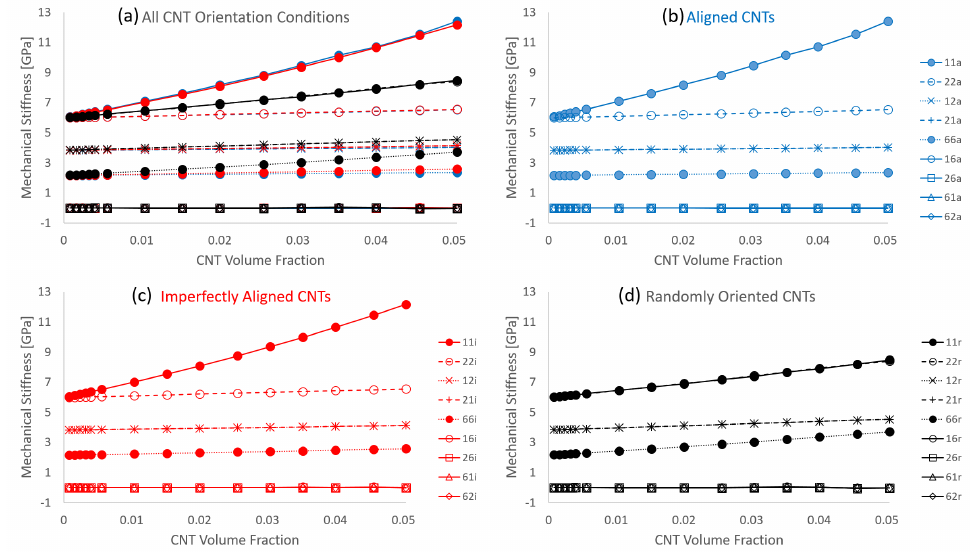
Figure 10. Mean of every stiffness tensor component C ij for ( a ) all 3 different orientation cases with straight CNTs, ( b ) straight ˜ x 1 aligned CNTs, ( c ) straight ˜ x 1 imperfectly aligned CNTs and ( d ) straight randomly oriented